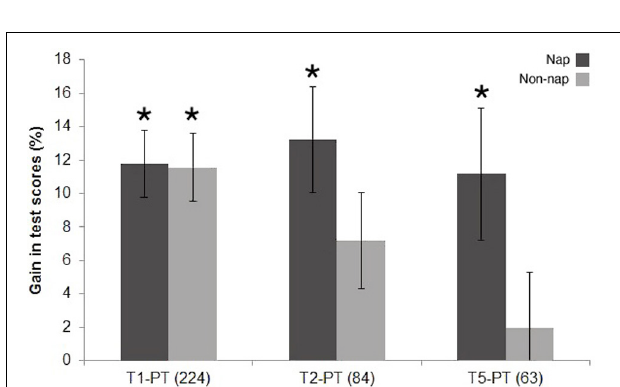
interactions between sleep (nap vs. no-nap) and time of testing (T0, T5, and T30) with regard to memory deterioration.